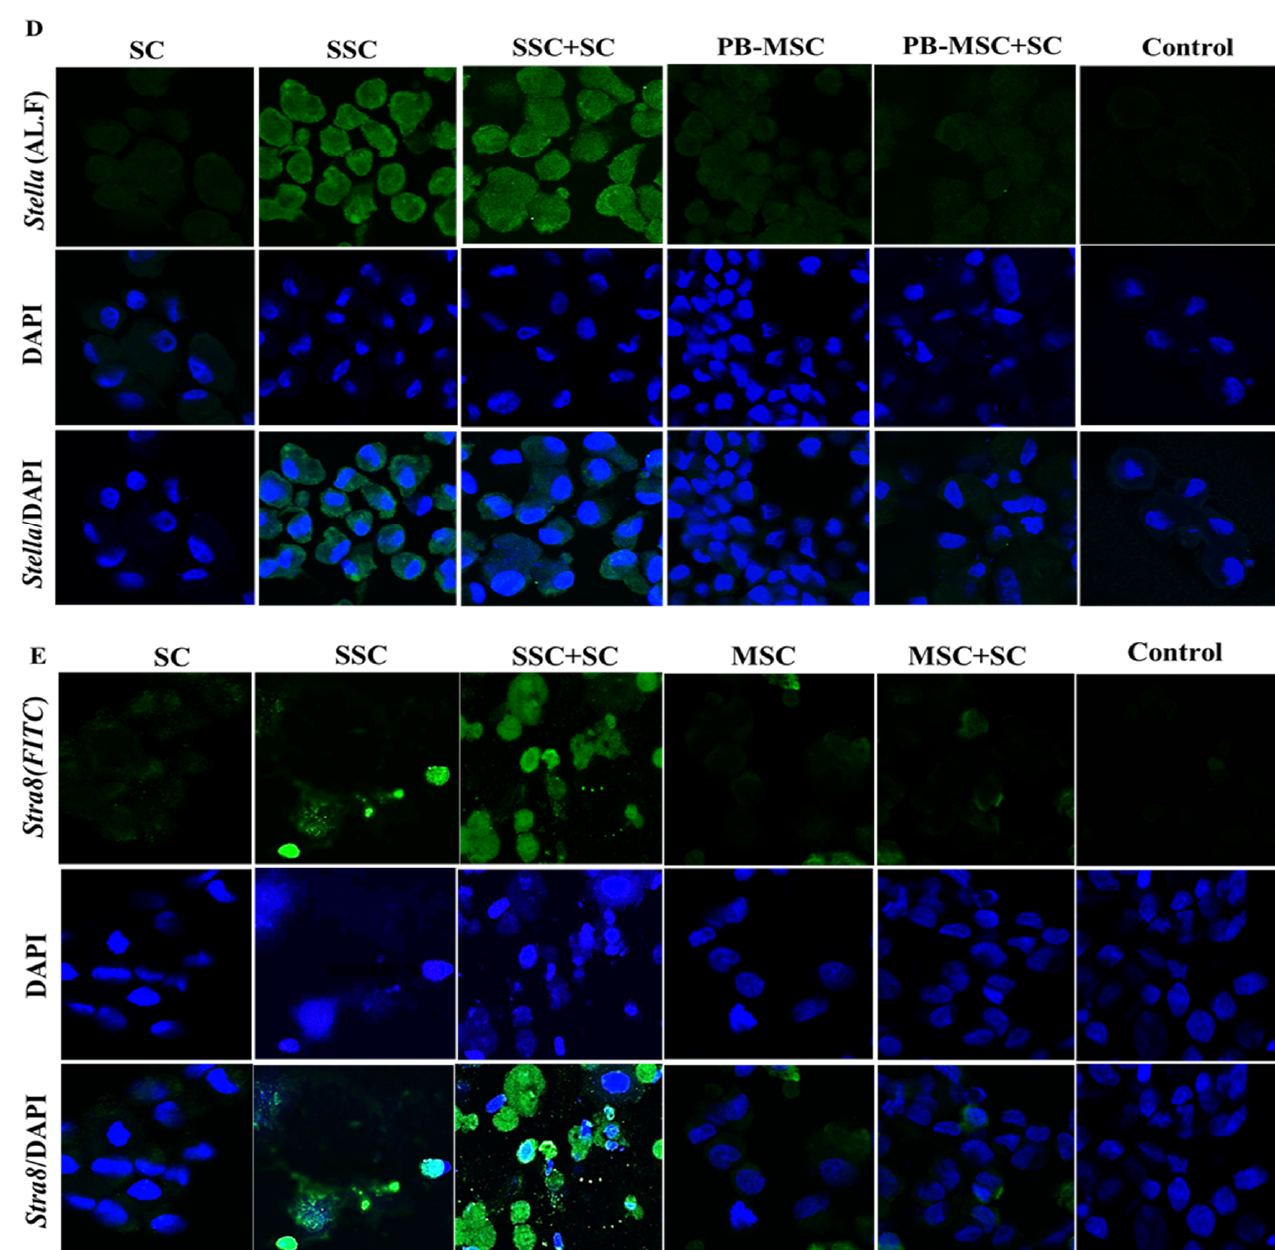
Figure 5. Expression of GC markers STELLA , FRAGILIS and STRA8 in single cultures and co-cultures of bull PB-MSC, SSC with SC in 3D SACS for 21 days. ( A–C ) Higher expression of STELLA was detected on days 7 and 14 in co-cultures of SSC+SC compared to SSC. ( B ) Expression levels of FRAGILIS expression were higher ( p < 0.05) in SSC+SC co-cultures compared to SC on days 7 and 14. ( C ) STRA8 gene expression was only detected in SSC+SC co-culture on day 14. ( D ) Immunofluorescence associated to STELLA was observed in SSC and SSC+SC co-culture at day 14. ( E ) STRA8 immunofluorescence was observed in SSC+SC co-culture at day 14. (*) Indicate gene expression was not detected in a single sampling day. Different superscripts (a, b) indicate differences ( p < 0.05) for the same marker between cell types and (1,2) for the same marker between culture